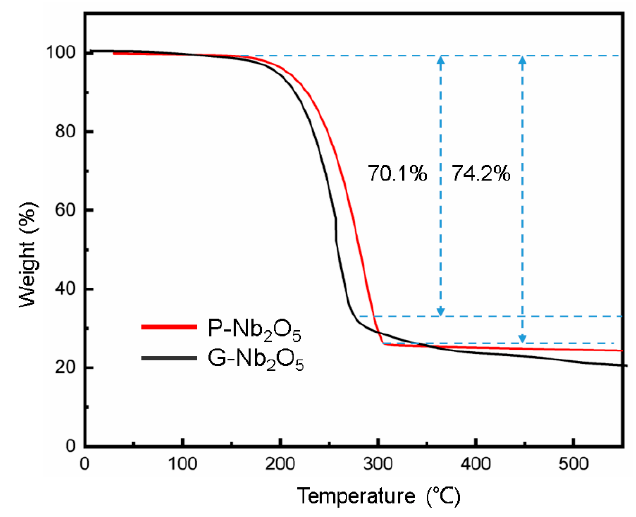
Figure 4. TGA curves of the P-Nb 2 O 5 and G-Nb 2 O 5 .